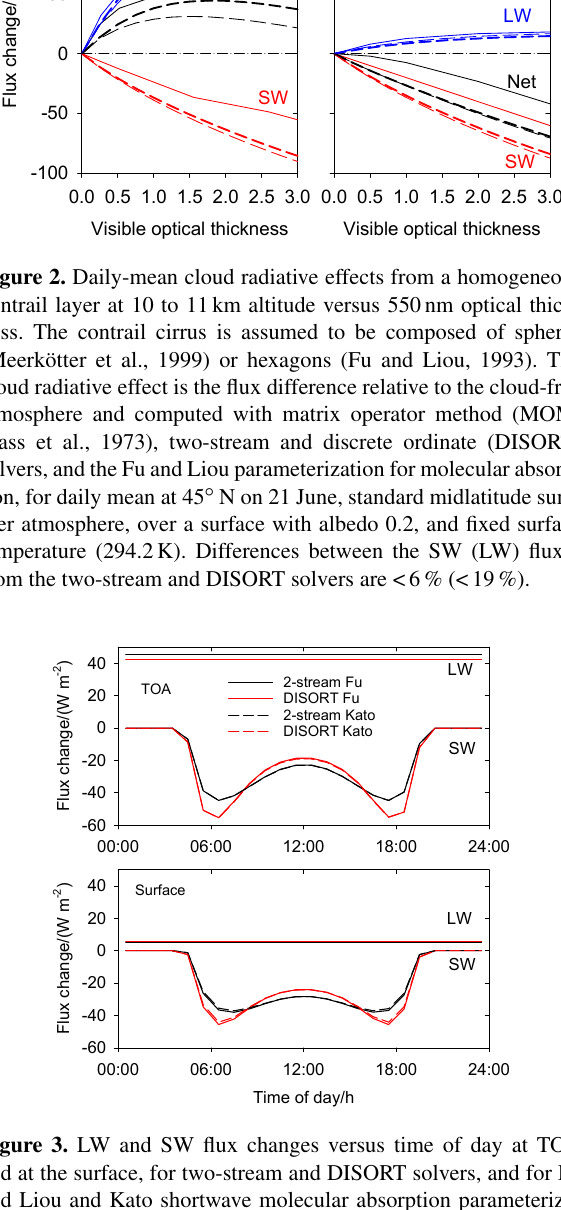
and for three different versions of vertical mixing: a “radia- tive case” with zero turbulent fluxes, a “radiative-convective case” with radiative transports and turbulent mixing in un- stably stratified layers, and a “radiative-diffusive case”